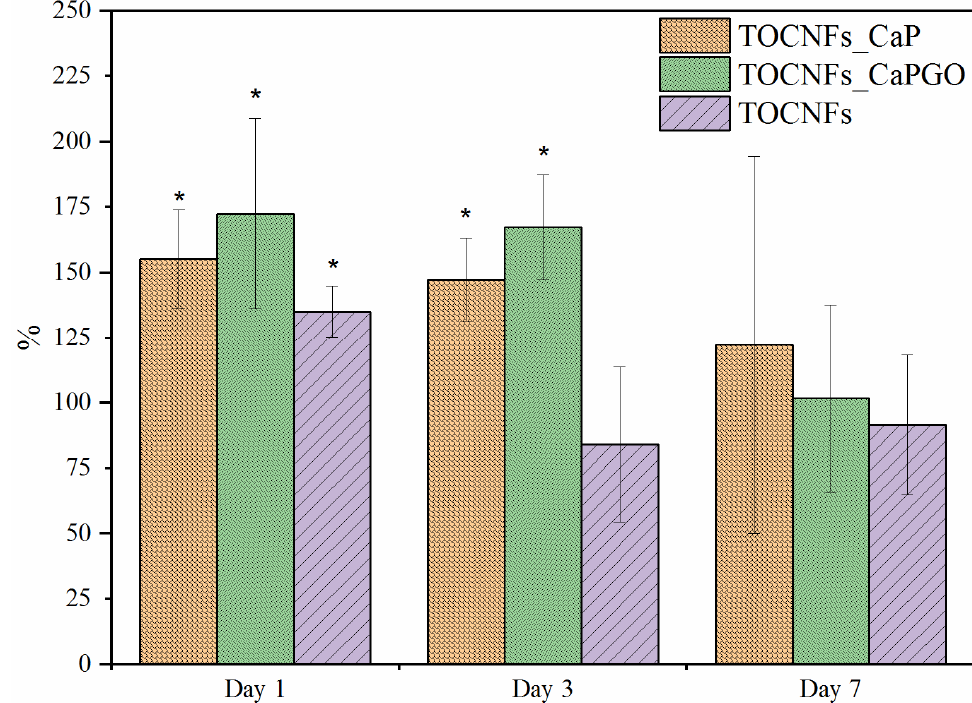
Figure 7. Viability of SAOS-2 cells incubated with eluates obtained from different hydrogels. * Statistically significant differences were evaluated by means of t-student test ( p < 0.05).